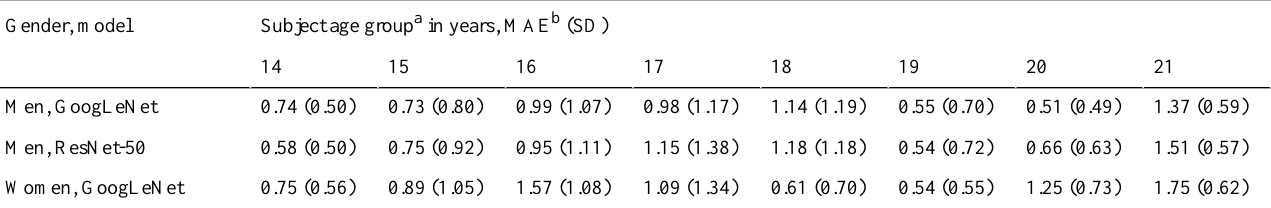
Table 2. Results from the experiments with the best-performing models: GoogLeNet and